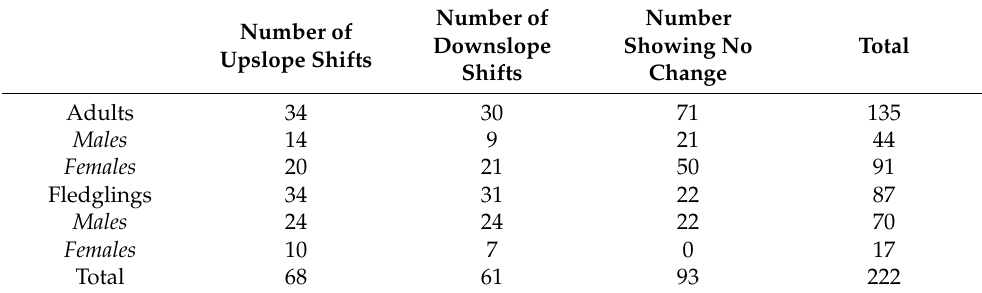
Table 1. The numbers of movements that were upslope, downslope, and showed no change for adults and fledglings. Both adults and fledglings have been split into males and females. Number Number of Number of Showing No Total Downslope Upslope Shifts Change Shifts Adults 34 30 71 135 Males 14 9 21 44 20 21 50 91 Fledglings 34 31 22 87 Males 24 24 22 70 Females 10 7 0 17 Total 68 61 93